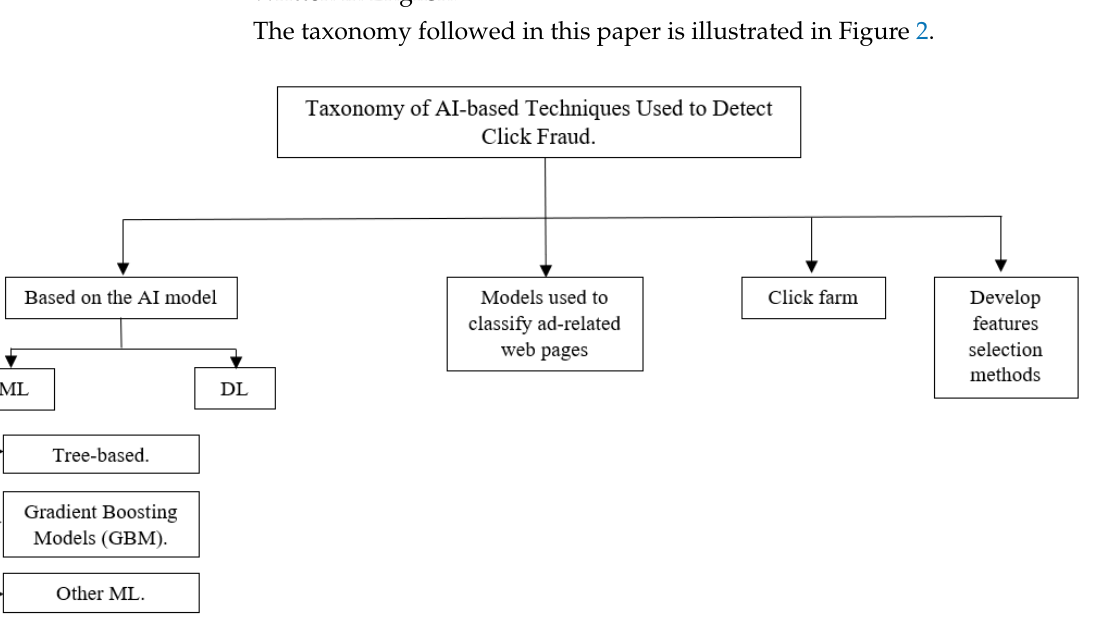
Figure 2. Taxonomy of the Literature